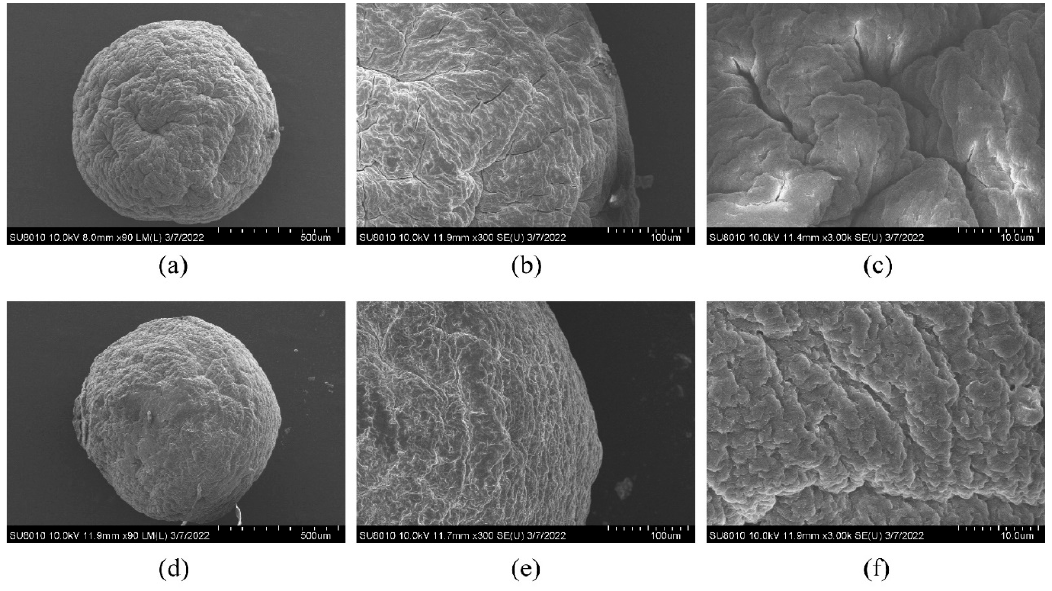
Figure 4. FSEM scanning micrographs of dry microcapsules. ( a – c ) are the structures of empty microcapsules at magnifications of 90 × , 300 × , and 3000 × , respectively; ( d – f ) are the structures of BEO microcapsules at magnifications of 90×, 300×, and 3000× under the optimum preparation process.